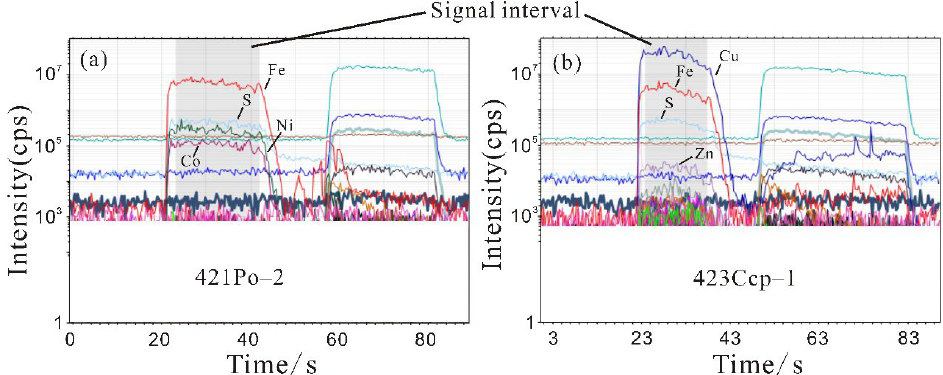
Figure 7. Examples of the time-resolved LA–ICP–MS depth profiles for the pyrrhotite and chalcopyrite from the Huangyangshan deposit. ( a ) Ablation profile for type I pyrrhotite from spot 421Po–2. ( b ) Ablation profile for type I chalcopyrite from spot 423Ccp–1.